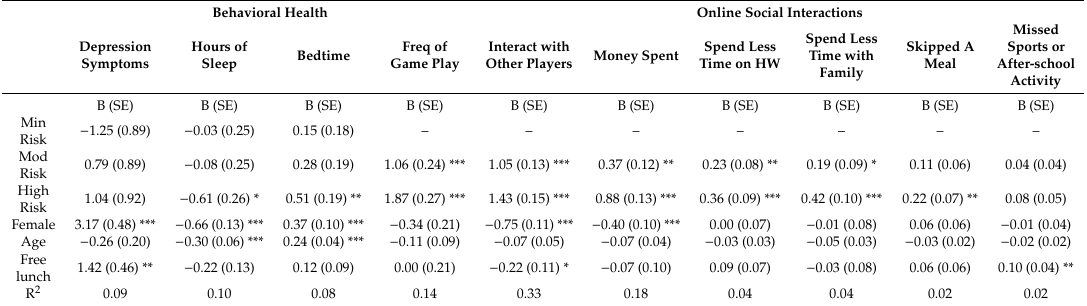
Table 4. Study 2: Gaming Risk on Adolescent Health and Online Social Interactions.